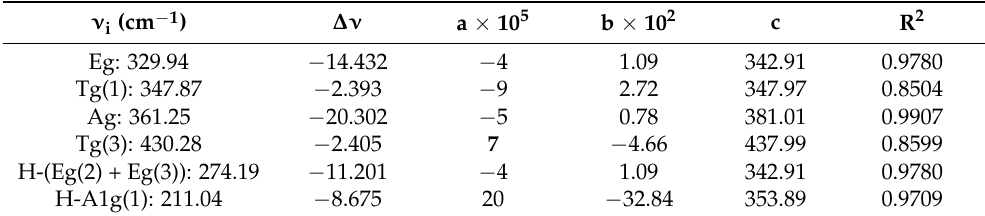
Table 3. Variable modes of Raman bands ( ∆ ν ) of pyrite with increasing temperature according to ν i = a T 2 + b T + c. ν i and ∆ ν are in cm − 1 , T in K, a and b have the corresponding units, c is a constant, and R 2 is the correlation coefficient.